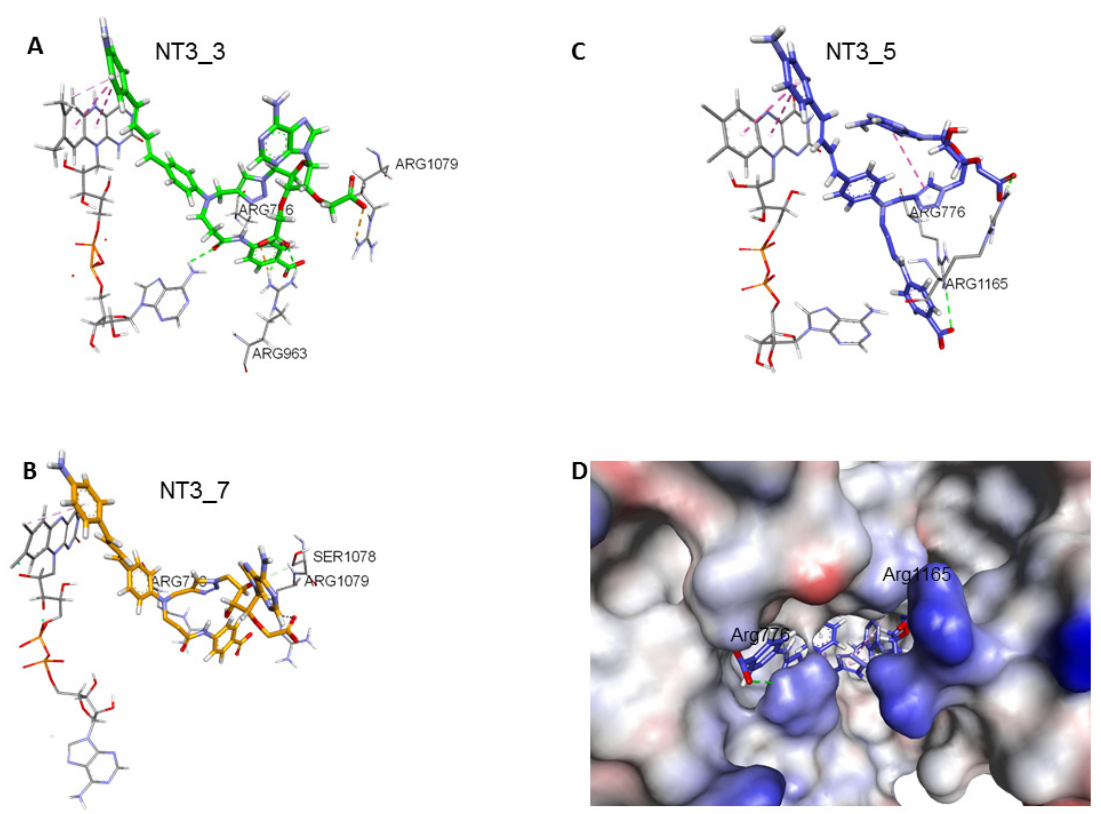
Figure 3. Comparison of NT3_5, NT3_7, NT3_3: effect of charge on key interactions between the